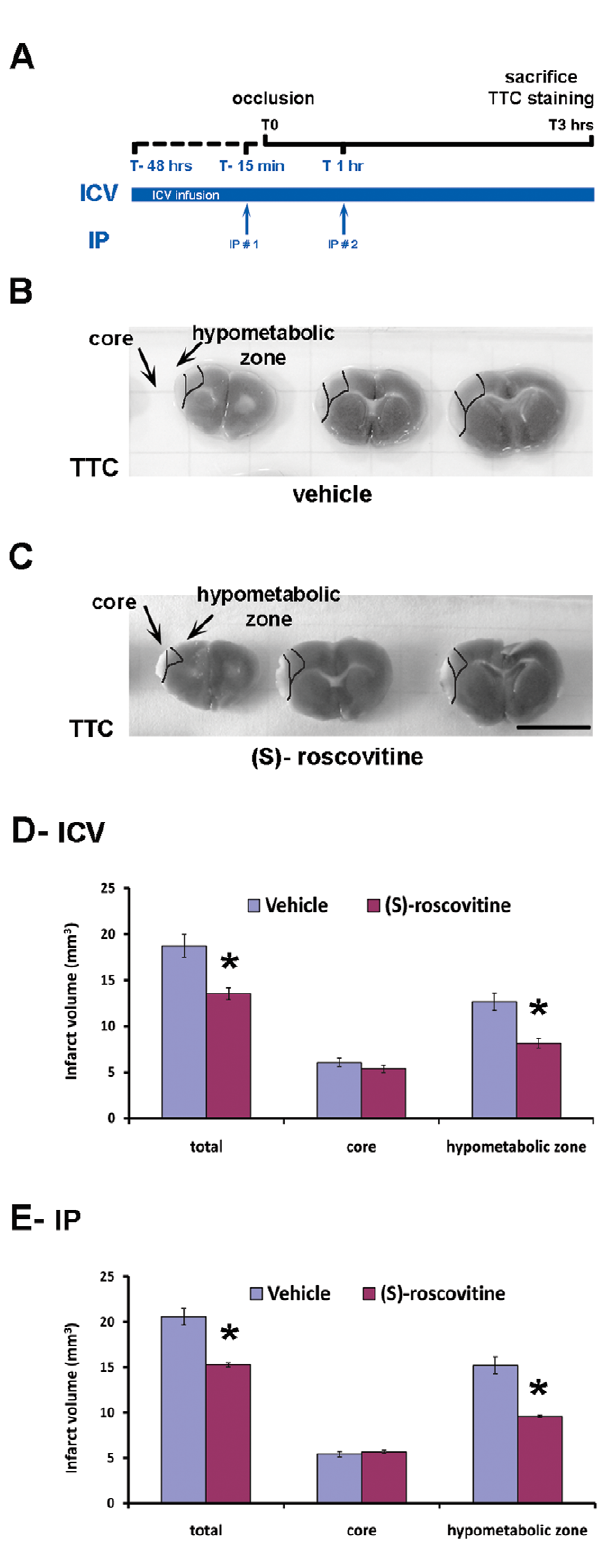
Figure 1. Systemic (S)-roscovitine displays neuroprotective efficacy in an adult mouse model of permanent MCAo. ( A ) Scheme of the experimental protocol. Vehicle or (S)-roscovitine were administered to pMCAo mice either by ICV infusion at a concentration of 500 m M starting 48 hrs before pMCAo or by two intraperitoneal (IP) injections at a dose of 25 mg/kg done 15 min pre- and 1 hr post-MCAo. Animals were sacrificed at 3 hrs after the occlusion and their brains